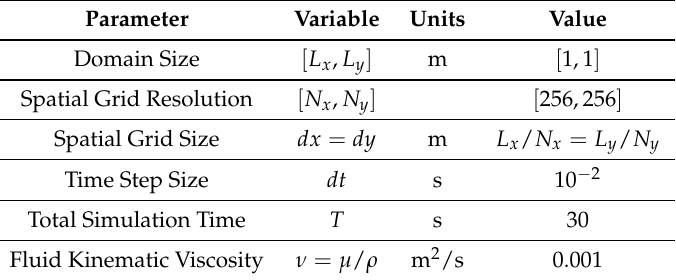
Table A1. Numerical parameters for case with ‘overlapping’ vorticity